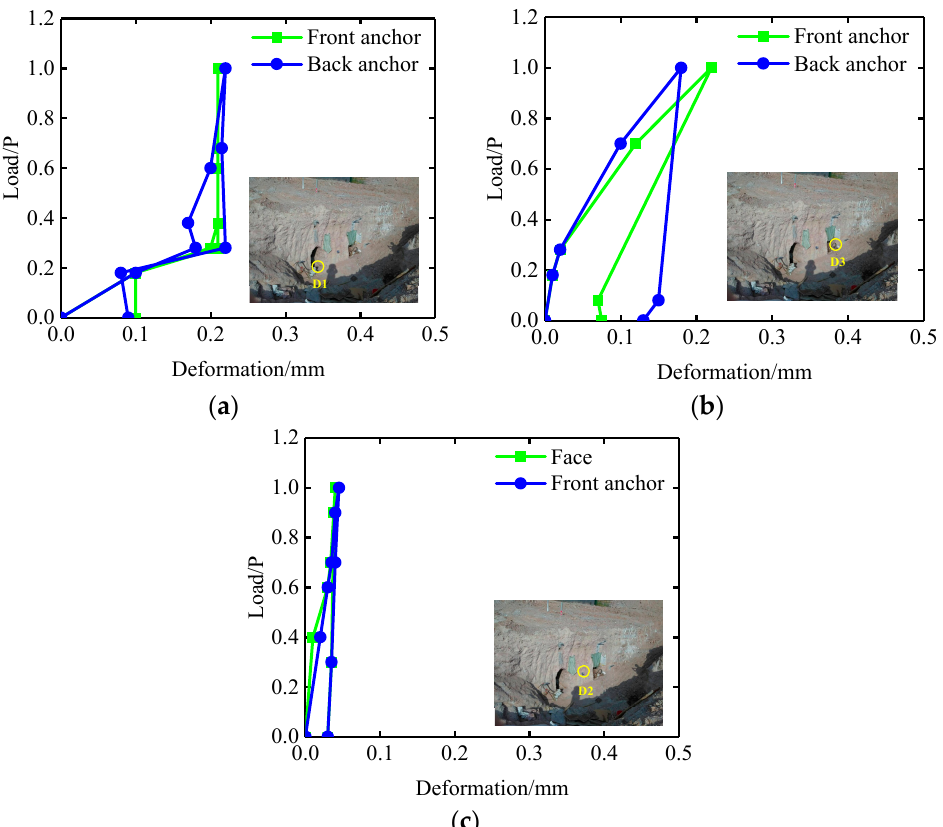
Figure 5. Deformation test results of anchor plug multi-point displacement meter: ( a ) D1; ( b ) D3; ( c ) D2.